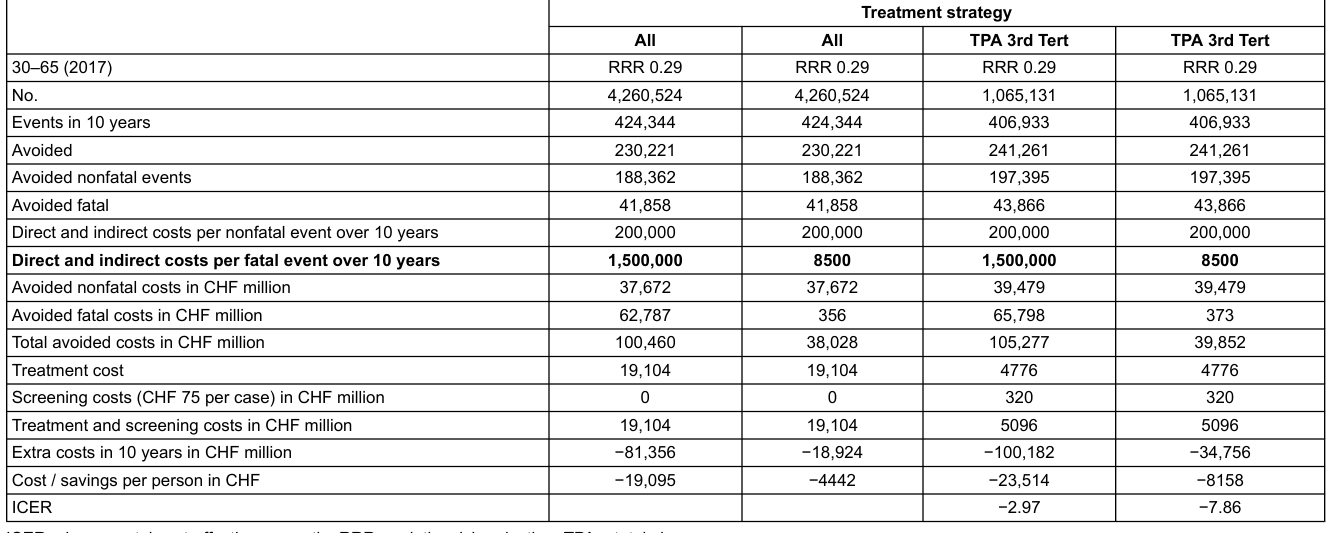
Treatment strategy